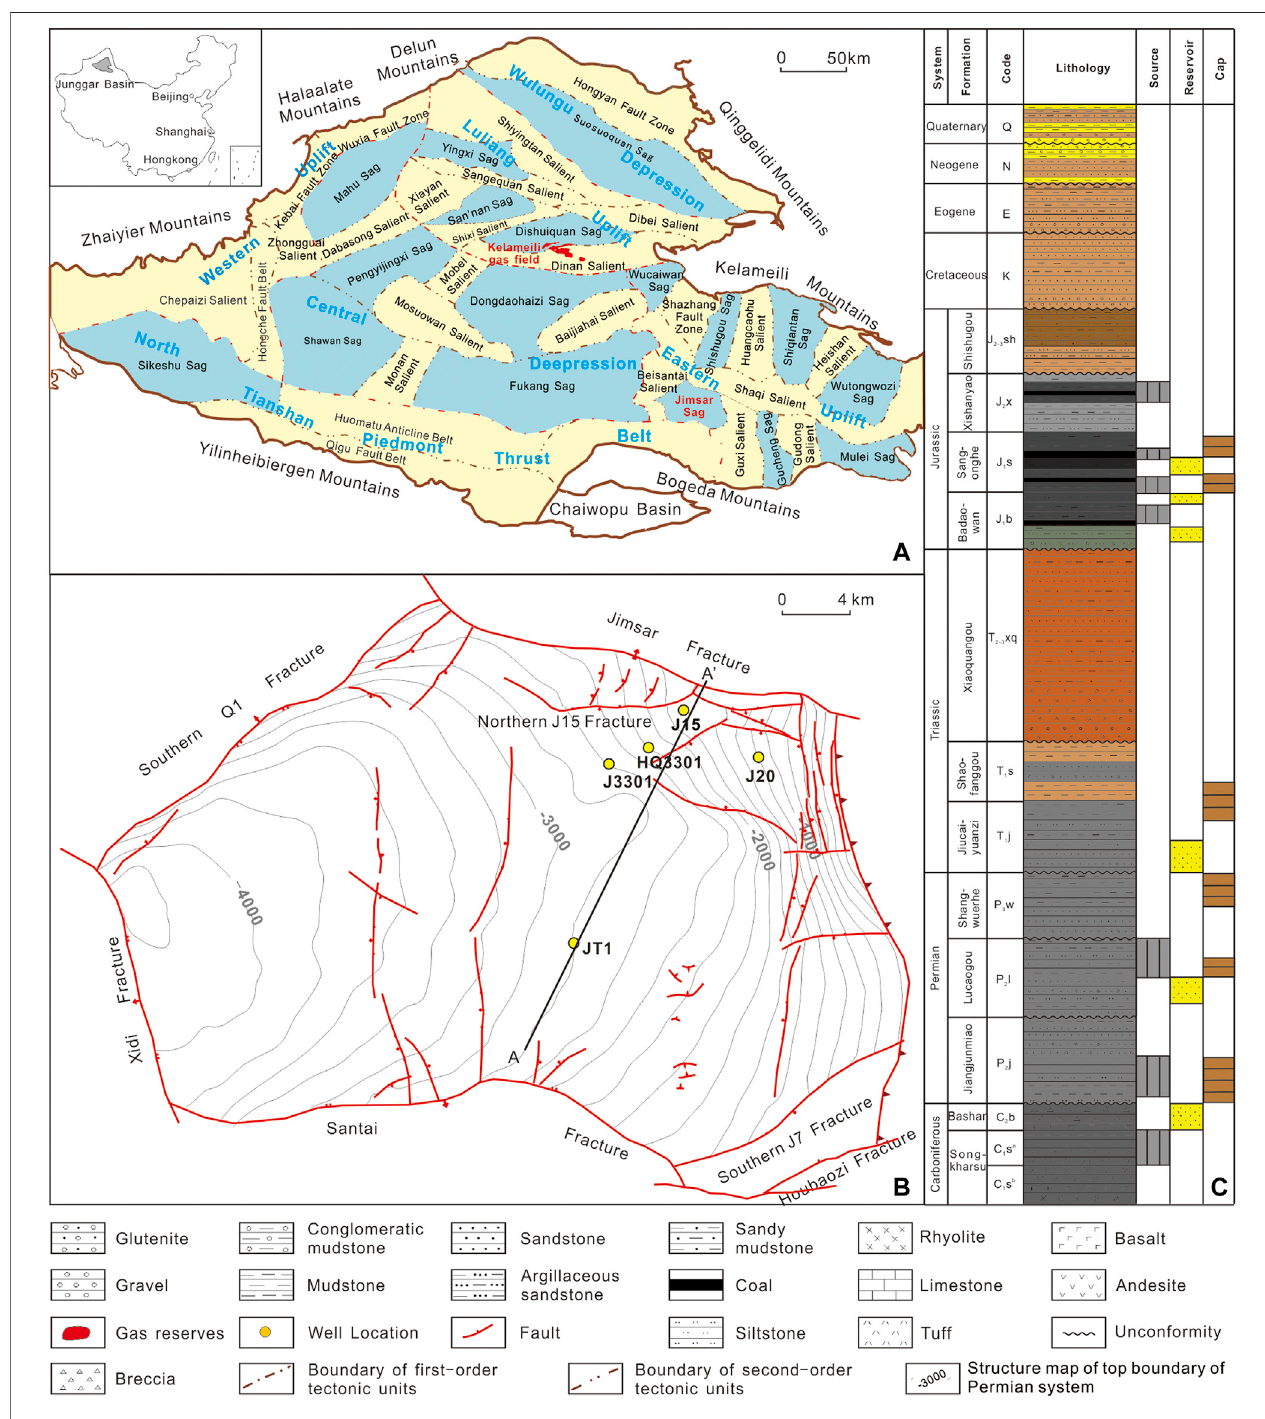
FIGURE 1 | Geological background of Jimsar Sag in the southeastern Junggar Basin. (A) : The geological setting of Junggar Basin; (B) : The geological setting of Jimsar Sag; (C) : The stratigraphic column in the Jimsar Sag.